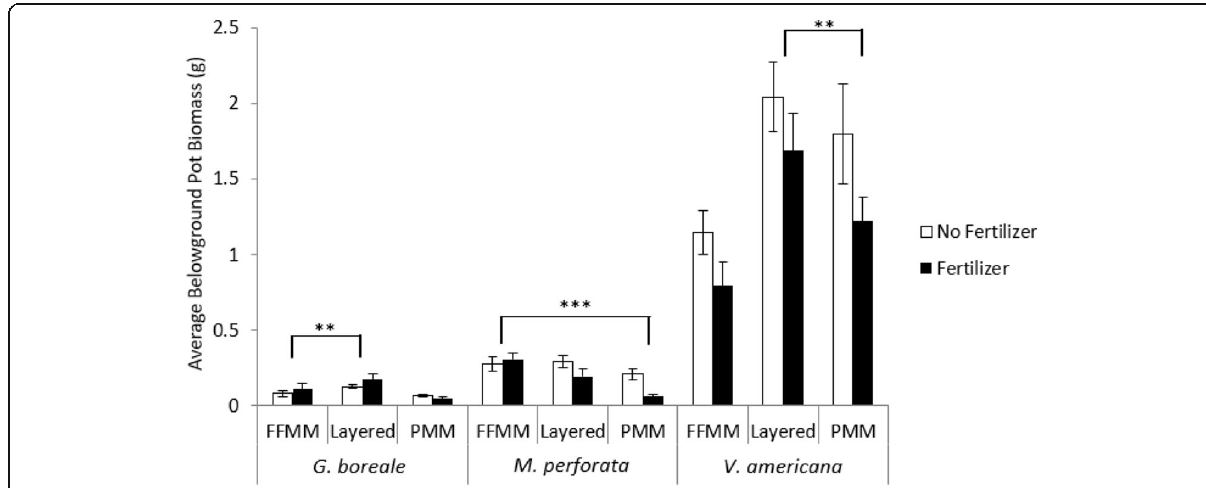
Fig. 2 Average belowground biomass per pot for pure species pots across both fertilizer treatments and the three soil types (forest floor-mineral mix, layered, and peat-mineral mix). Bars indicate standard error, and asterisks represent p values generated from post hoc analysis (Tukey ’ s test) that compares subset species across soil treatments (*** p < 0.001, ** p < 0.01, * p <